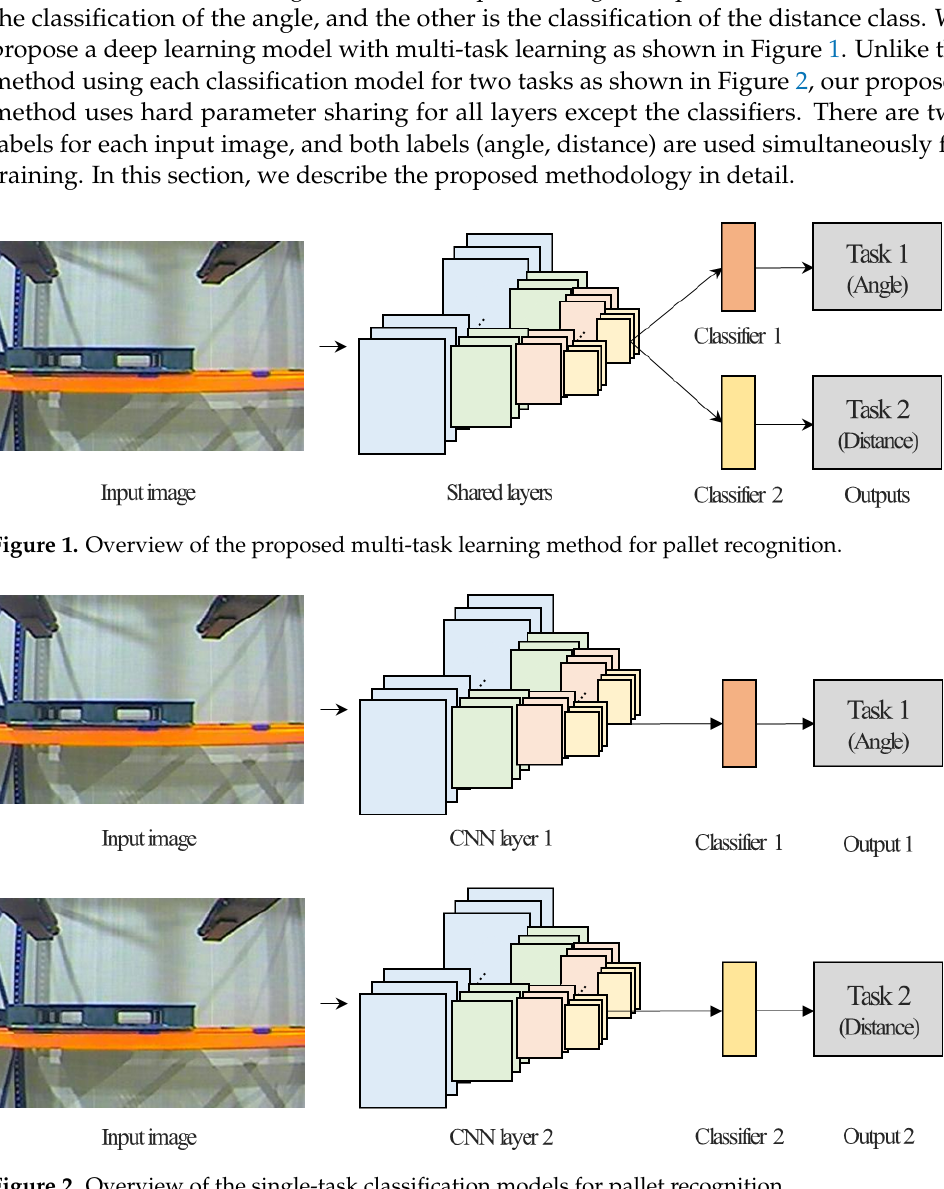
Figure 2. Overview of the single-task classification models for pallet